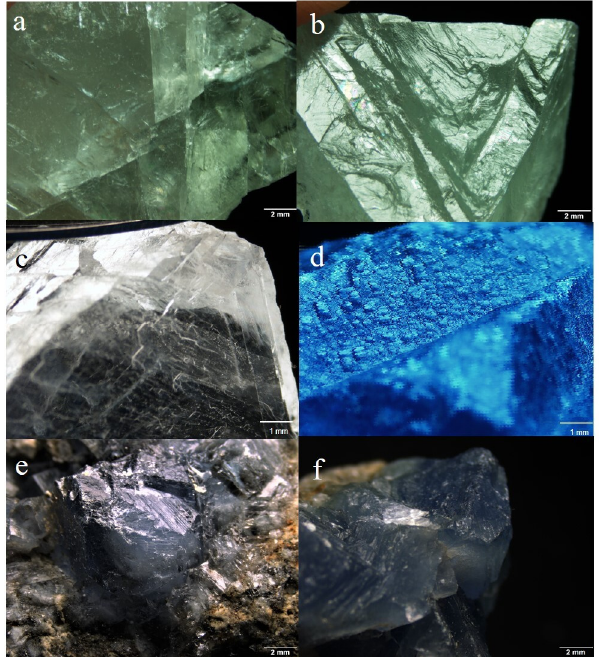
Figure 4. Characteristics of fluorite samples under the gemological microscope: ( a ) cleavage lines; ( b ) stepped fracture; ( c ) internal cleavage plane; ( d ) growth mound; ( e ) coniferous lines; ( f ) internal bands.